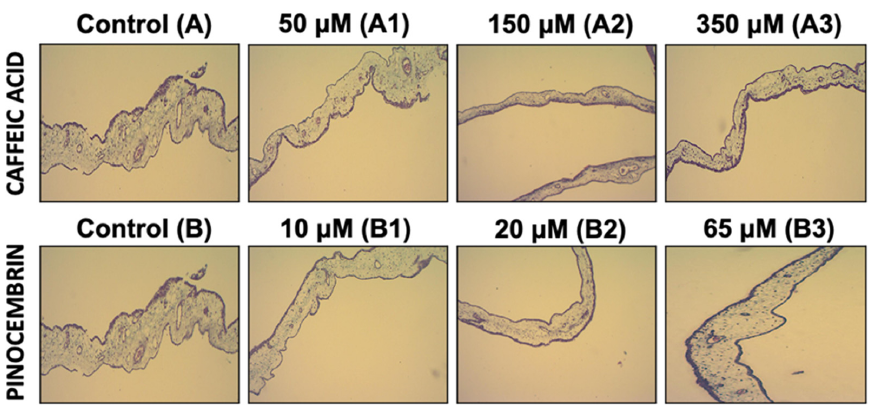
Figure 3. Antiangiogenic effect of treatment with caffeic acid and pinocembrin in solution on the formation of blood vessels in the chorioallantoic membrane of embryonated chicken eggs. ( A1 – A3 ): Representative images of formation of blood vessels in embryonated chicken eggs treated with increasing concentrations of caffeic acid. ( B1 – B3 ): Representative images of formation of blood vessels in embryonated chicken eggs treated with increasing concentrations of pinocembrin.